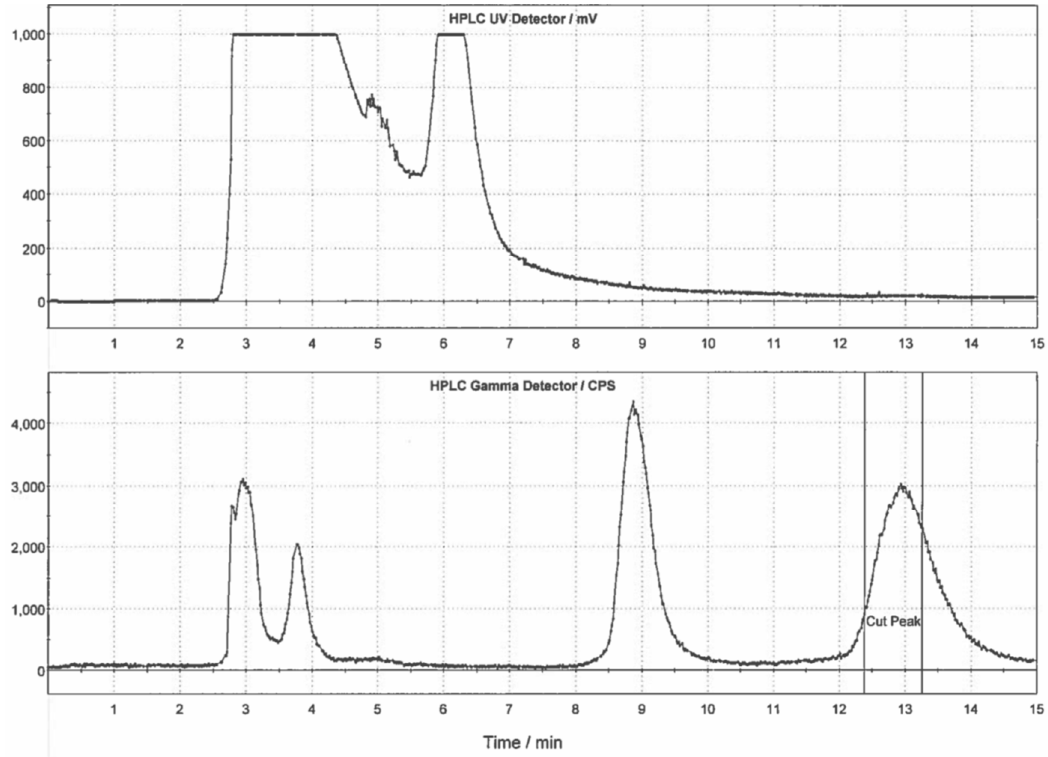
Figure 4. Typical semi-preparative HPLC trace for [ 11 C]AZ683.